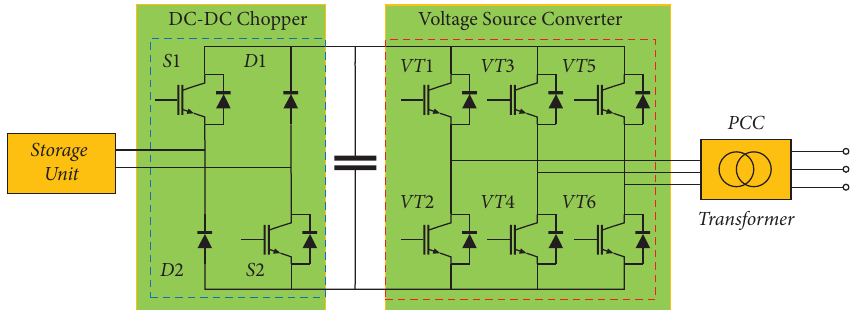
Figure 6: Connection of the storage unit to the PCC via a DC\DC and VS Table 3: ESS-related studies in many structures.